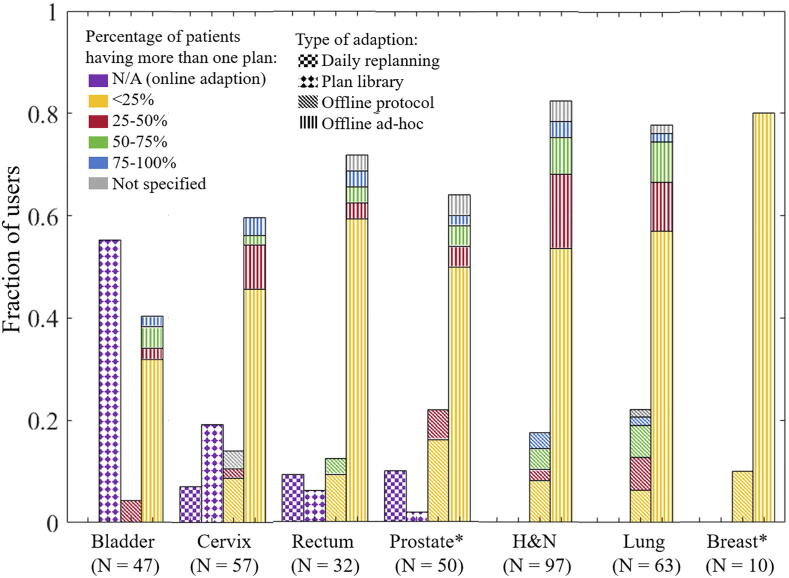
For the various tumour sites, fractions (bar heights) of users applying the defined four types of ART (bar pattern). Colours show percentage of patients having more than one plan for the offline approaches. For breast and prostate, one institution did not specify the type of ART.